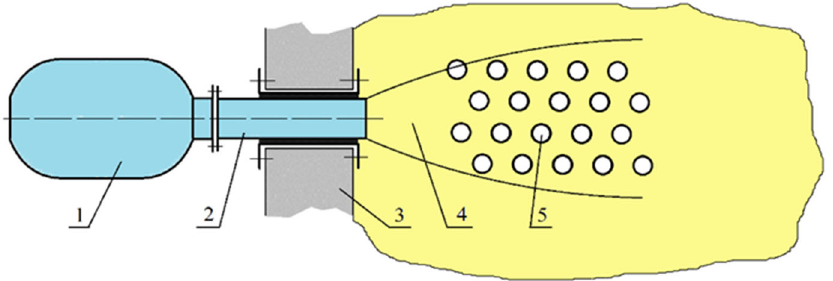
Figure 1. Typical diagram of the air impact generator for tubular heat exchanger cleaning. 1—air impact generator; 2—exhaust nozzle; 3—boiler wall; 4—impulse gas jet; 5—heat exchange tubes.